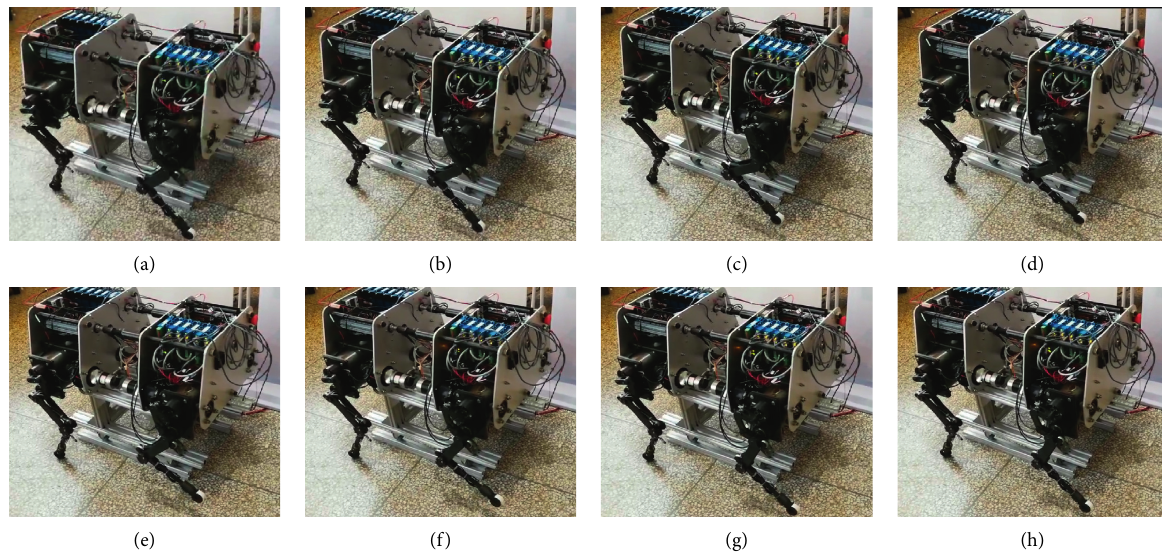
Figure 18: Movement process of foot-end of prototype. (a) Start. (b) 1/7 period. (c) 2/7 period. (d) 3/7 period. (e) 4/7 period. (f) 5/7 period. (g) 6/7 period. (h) 1 period.